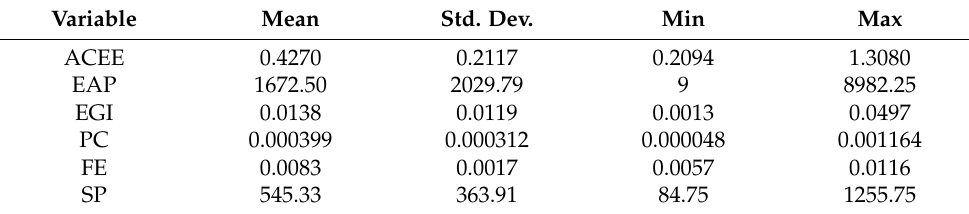
Table 3. Descriptive statistical analysis of each variable.